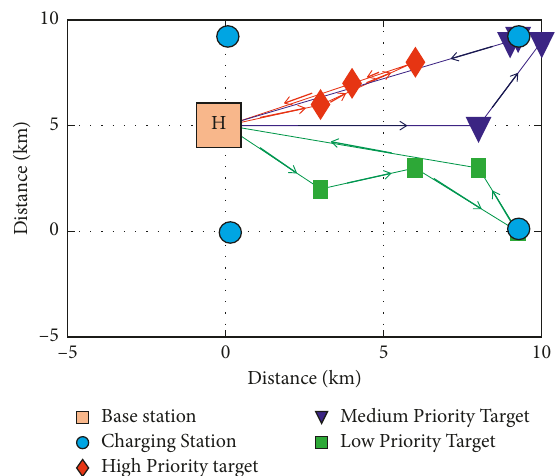
Figure 12: Calculated optimal routes for the optimal number of charging